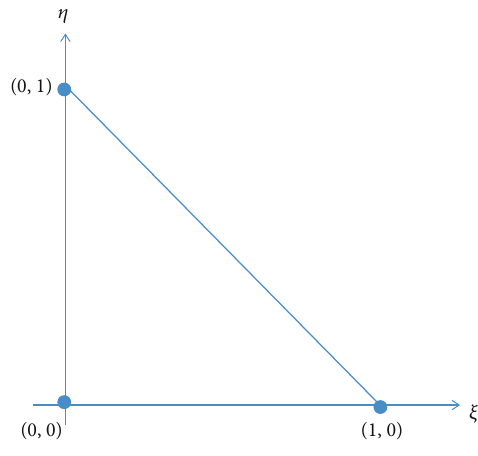
Figure 3: A usual reference element ̂ T ∈ ℝ 2